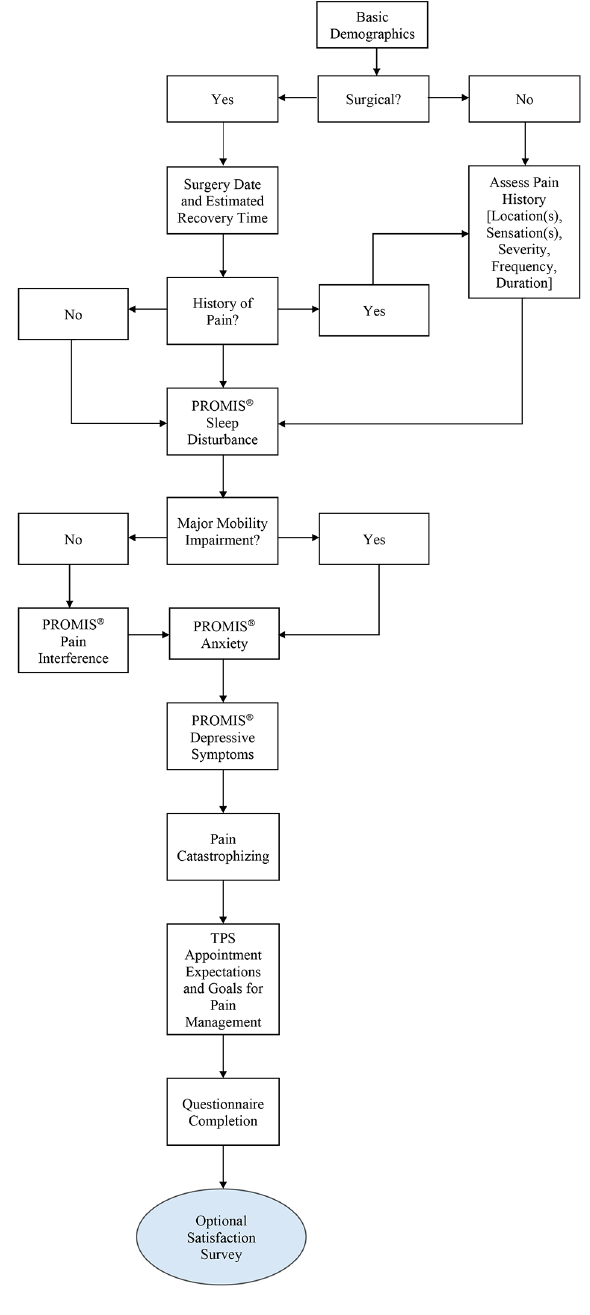
Fig. 2 Final Questionnaire